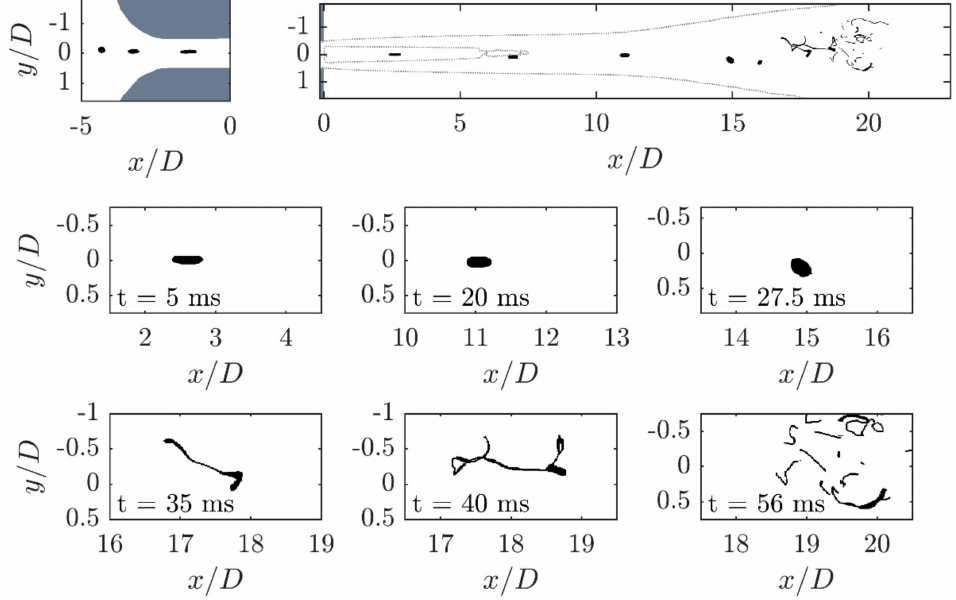
Figure 25. Development of droplet break-up at a high viscosity ratio ( λ = 10.8) at Re =